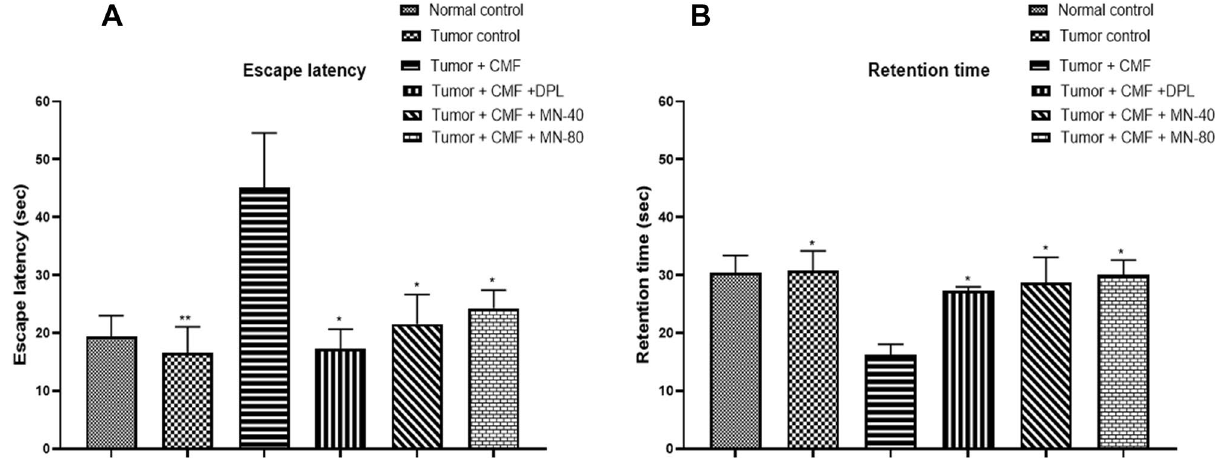
Figure 4. Effect of Mulmina (MN), Cyclophosphamide + Methotrexate + 5-Fluorouracil (CMF), Donepezil (DPL) on ( A ) Escape latency ( B ) Retention time on tumor-bearing animals in MWM retention trial . Values are expressed as mean ± SEM (n = 3–4). Statistical analysis was done by using one-way ANOVA followed by Dunnet’s post-hoc test .* p < 0.05,** p < 0.01 compared to tumor + CMF treated group.